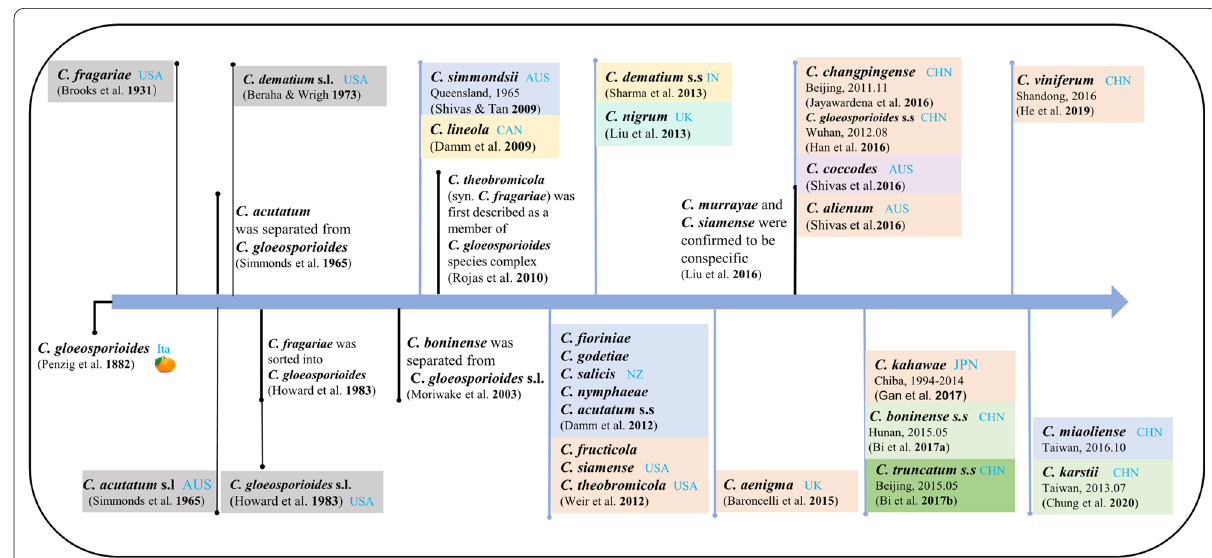
Fig. 1 A timeline of reports about Colletotrichum species pathogenic to strawberry. Years for reports (in brackets) and original sampling (if available) were indicated, and abbreviations of geographic locations (if specific) were shown for pathogen origins. Relevant findings of mycologists (unshaded) and strawberry pathologists (shaded) were sequentially marked on the central time axis not to scale. Early reports not distinguished at the species level were indicated in gray boxes. A total of 23 Colletotrichum species currently accepted were illustrated in distinct colors, which include orange for nine species of C. gloeosporioides s.l., light blue for seven of C. acutatum s.l., yellow for two of C. dematium s.l., light green for two of C. boninense s.l., and dark green for one of C. truncatum s.l., respectively, as well as two singletons C. nigrum and C. coccodes . s.l. and s.s indicate sensu lato (complex) and sensu stricto,